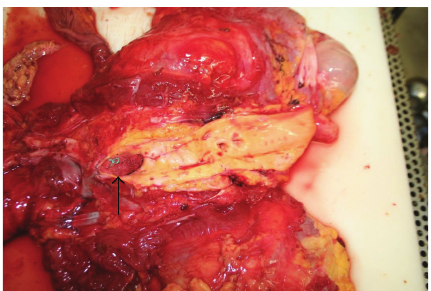
Figure3:Postmortempicturesdemonstratingswabimpactedatthe aortic bifurcation (black